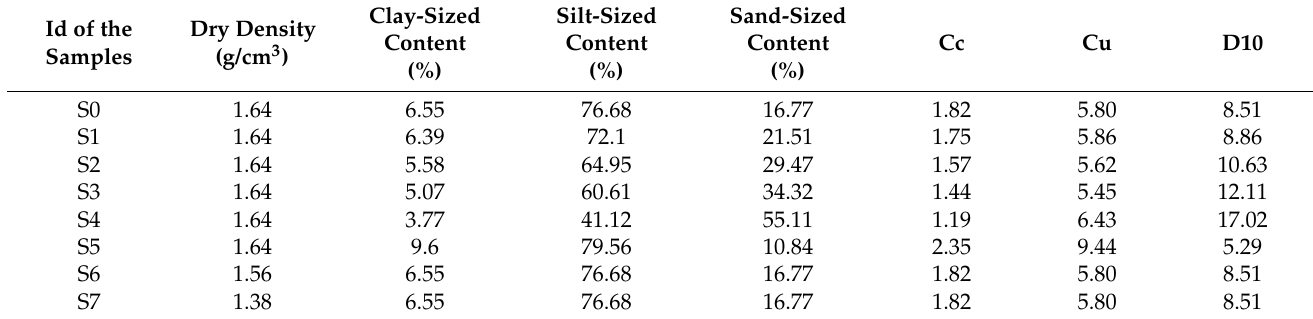
Table 2. SWCC testing scheme.